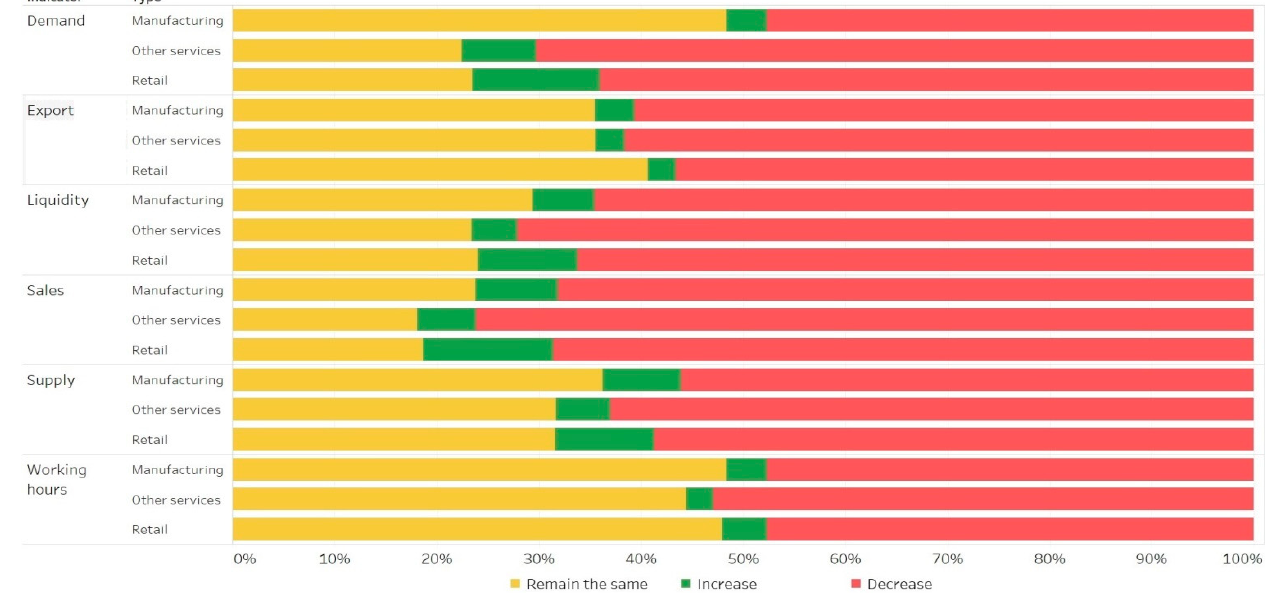
Figure 3. Performance of companies in various aspects depending on the sector. Table 3. Percentage of companies that remained open or were temporarily or permanently closed.